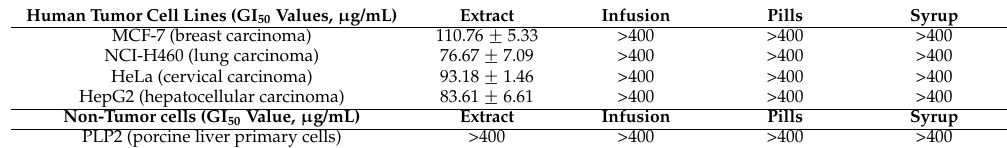
GI 50 values correspond to the sample concentration achieving 50% of growth inhibition in human tumor cell lines or in liver primary culture PLP2. Ellipticine GI 50 values: 1.21 µ g/mL (MCF-7), 1.03 µ g/mL